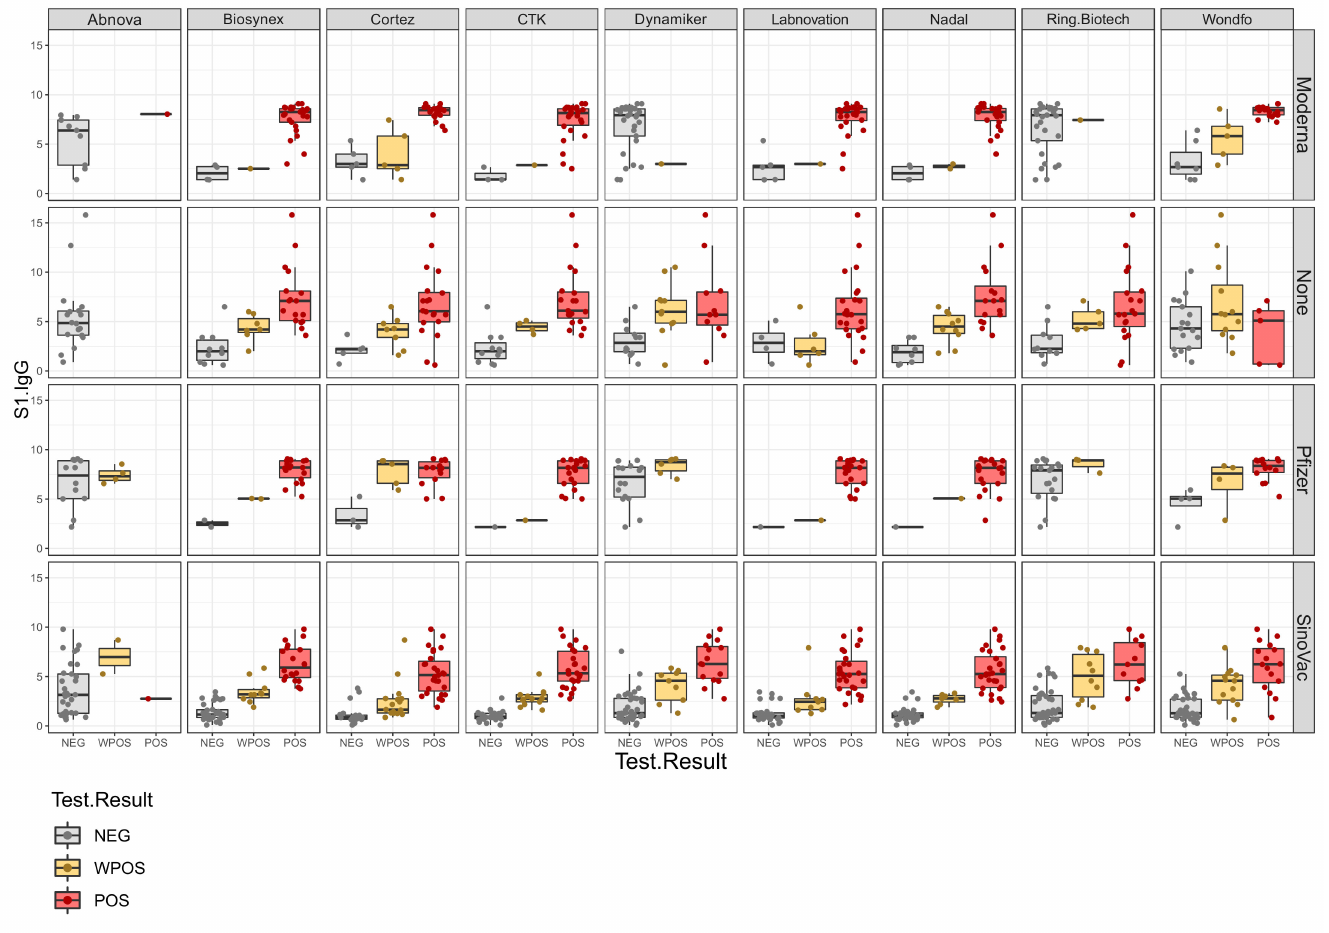
Figure 2. Semiquantitative LFA responses ( x -axis) versus anti-spike IgG response ( y -axis) sorted by vaccine (Moderna and Pfizer represent mRNA vaccine, SinoVac represents inactivated virus vaccine, and None represents the post-infection cohort). Results are categorized as negative IgG response (NEG), weak positive IgG response (WPOS), and positive IgG response